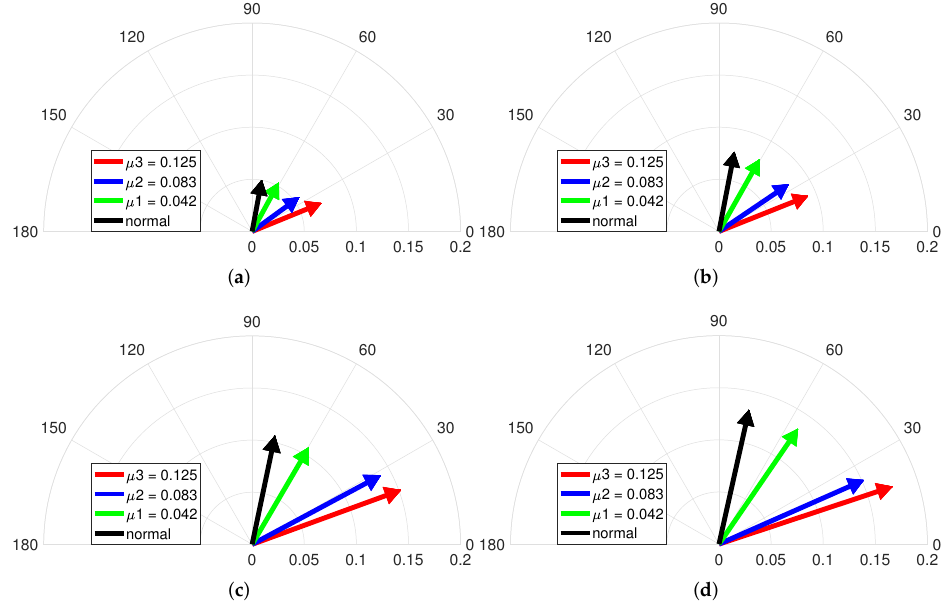
Figure 10. Vector diagram at ( a ) 2000, ( b ) 3000, ( c ) 4000, and ( d ) 4500 rpm and no-load with µ